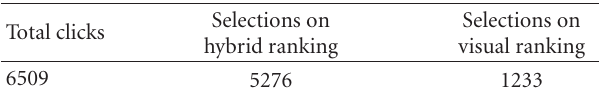
Table 5: Clicks on hybrid and visual